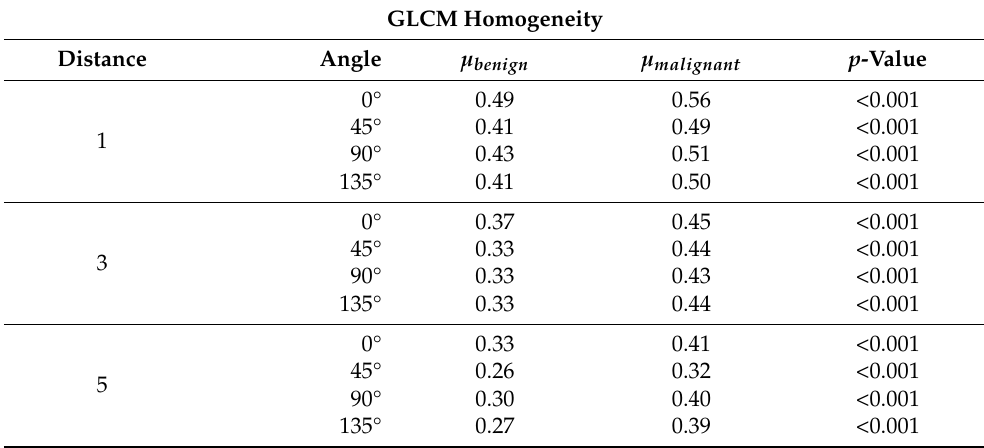
Table A7. The gray level co-occurrence matrix homogeneity feature measured across three